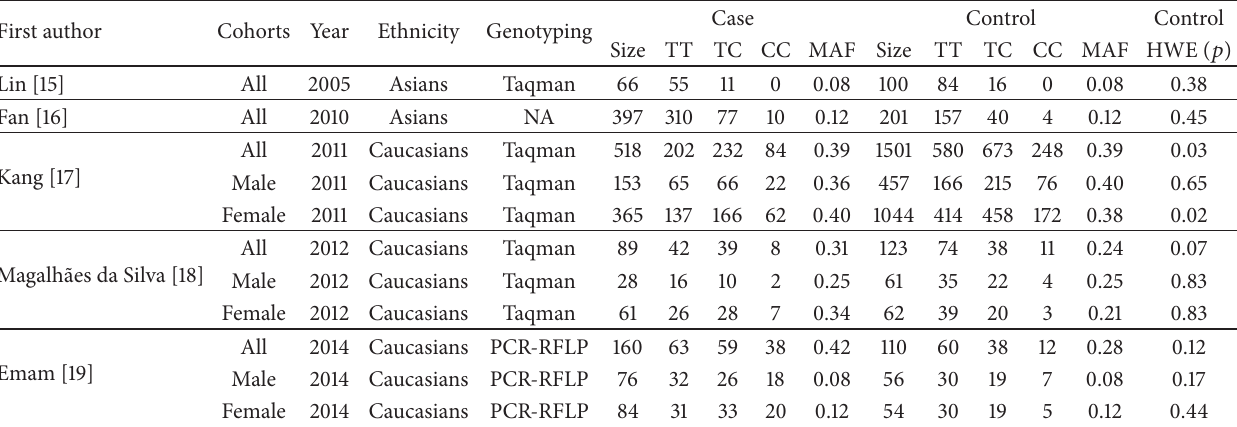
Table 2: Principle characteristics of the studies included in the meta-analysis for association between eNOS rs1799983 and POAG.